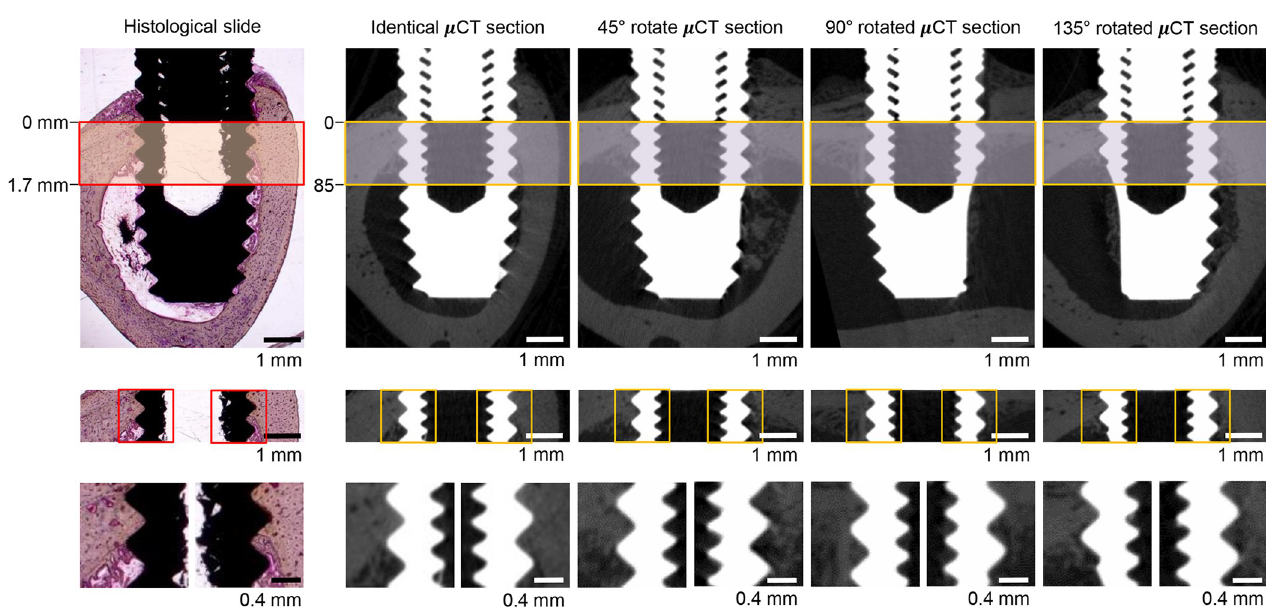
Fig 3. Region of interest for bone-to-implant contact ratio measurement. The boxed areas in the upper and middle panels show the cropped regions used for BIC ratio measurements. The analysis included 85 2D- μ CT slices and a 1.7 mm histologic section from the bottom of the healing abutment. Each side of the implant surface was evaluated independently (lower